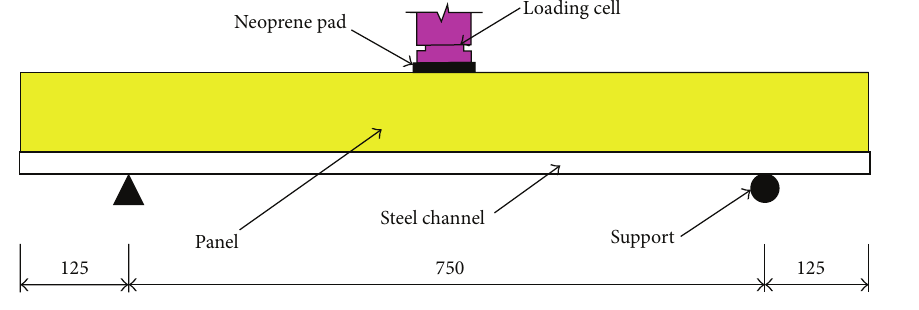
Figure 3: Test setup.